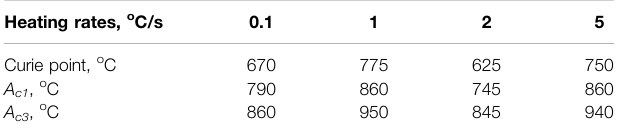
Frontiers in Materials |